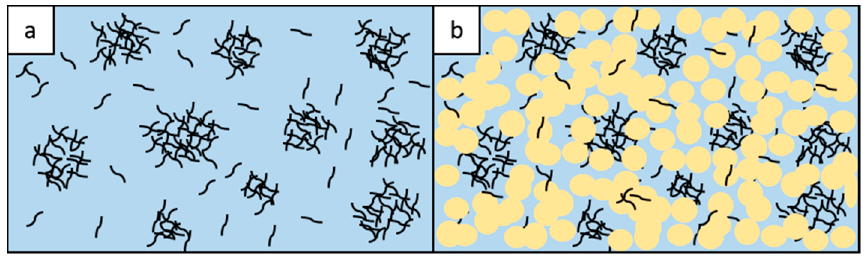
Figure 3. Schematic illustrations of ( a ) TPU/MWCNT composites, showing the MWCNT-rich zones and ( b ) TPU/PZT/MWCNT composites, showing MWCNT-rich and PZT-rich zones.